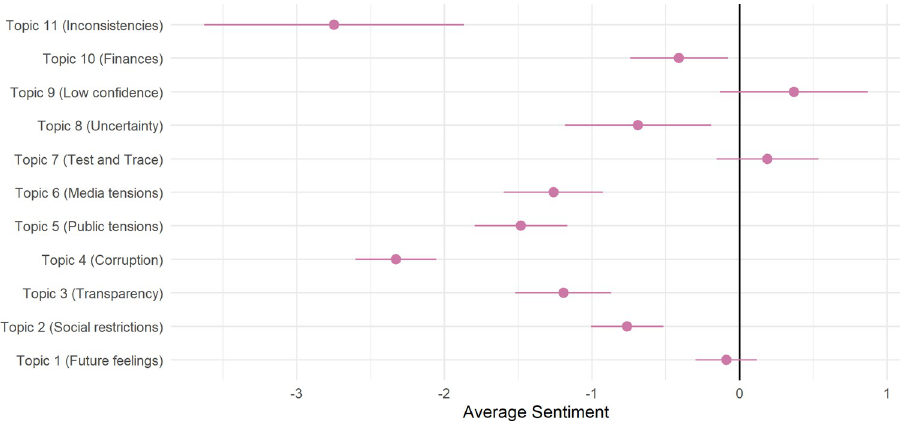
Fig 5. Sentiment analysis. Results of linear regression of average sentiment on topic proportions in